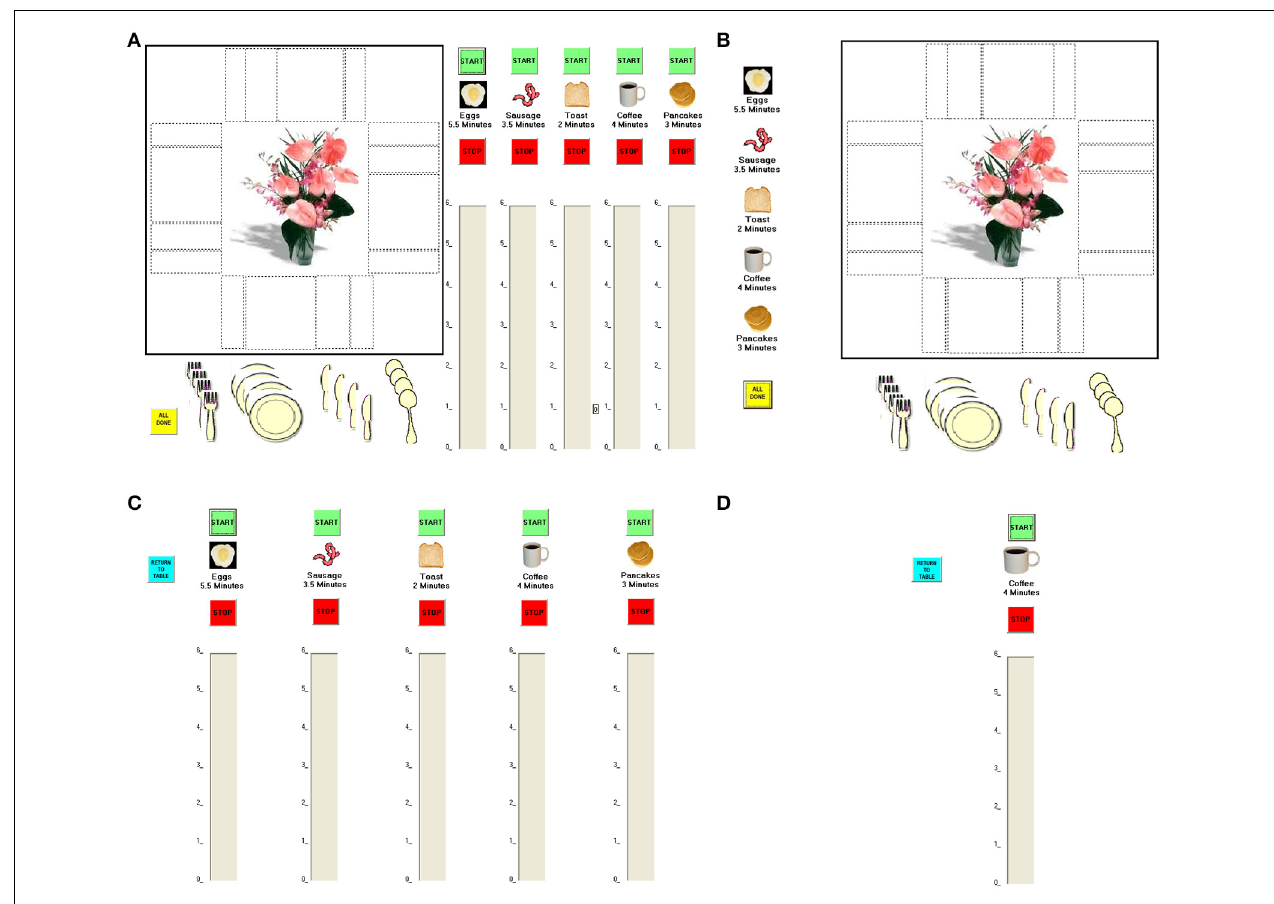
FIGURE 1 | The Breakfast Task versions. (A) The 1-screen version: The five foods and the table are shown on a single screen. (B,C) The 2-screen version: The five foods are shown on one screen and the table on a separate one. (B,D) The 6-screen version: The five foods and the table are shown on a separate screen.